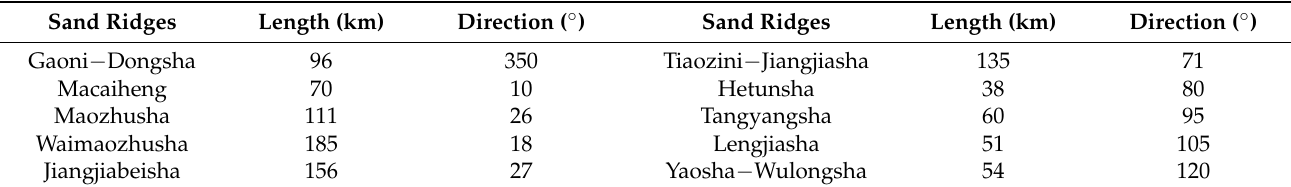
Table 2. Statistical table of morphological parameters of sand ridges. Sand Ridges Length (km) Direction ( ◦ ) Sand Ridges Length